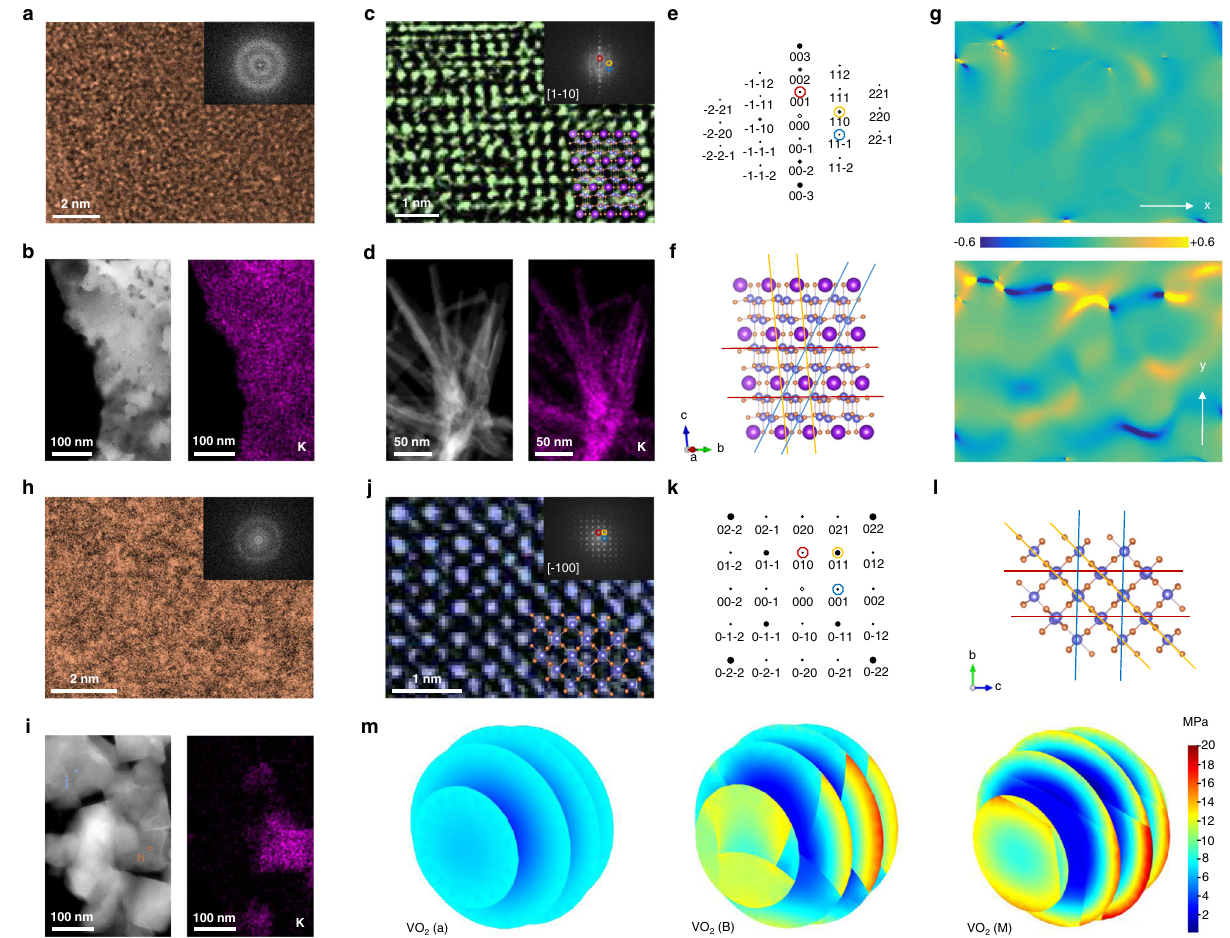
Fig. 5 | Structural and stress analysis during cycling. HRTEM images at atomic resolution and theirrelated FFTpatterns of a VO 2 (a), c VO 2 (B),and h)amorphous region of VO 2 (M) (the tan squared areas in Fig. 5i, j) crystalline region of VO 2 (M) (thedarkbluesquaredareasinFig.5i)atdischargedstateafter100cycles.HADDF- STEM imagesand corresponding elementalmappingsofKfor b VO 2 (a), d VO 2 (B), and i VO 2 (M). The simulated diffraction patterns of ( e ) VO 2 (B) and ( k ) VO 2 (M).